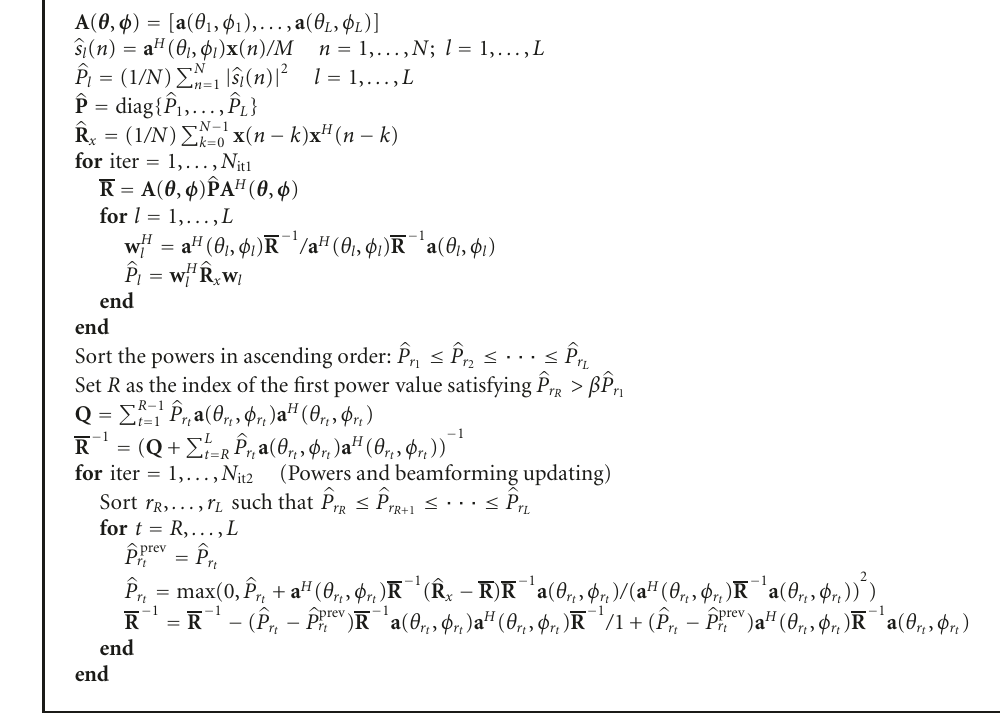
Algorithm 4: IAA-ML-RC Algorithm.